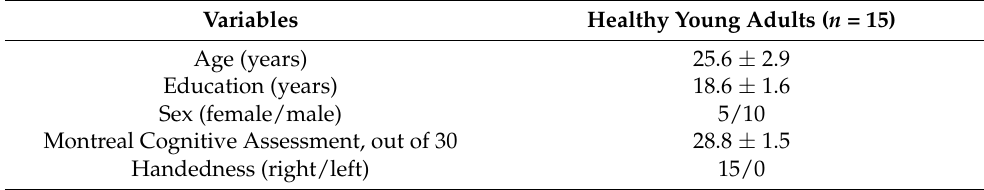
Table 1. Demographic characteristics.